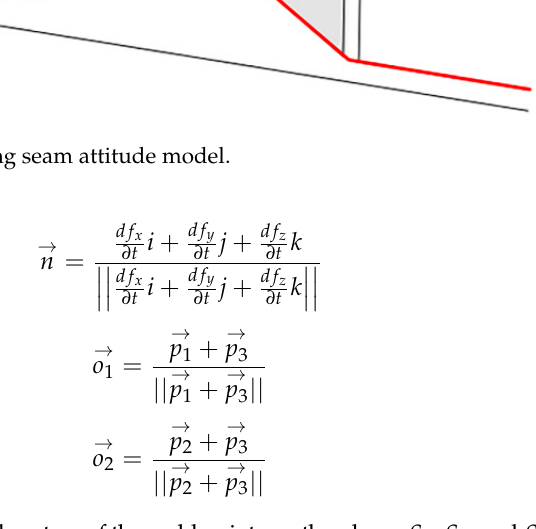
Figure 8. 3D zigzag-line welding seam attitude model.